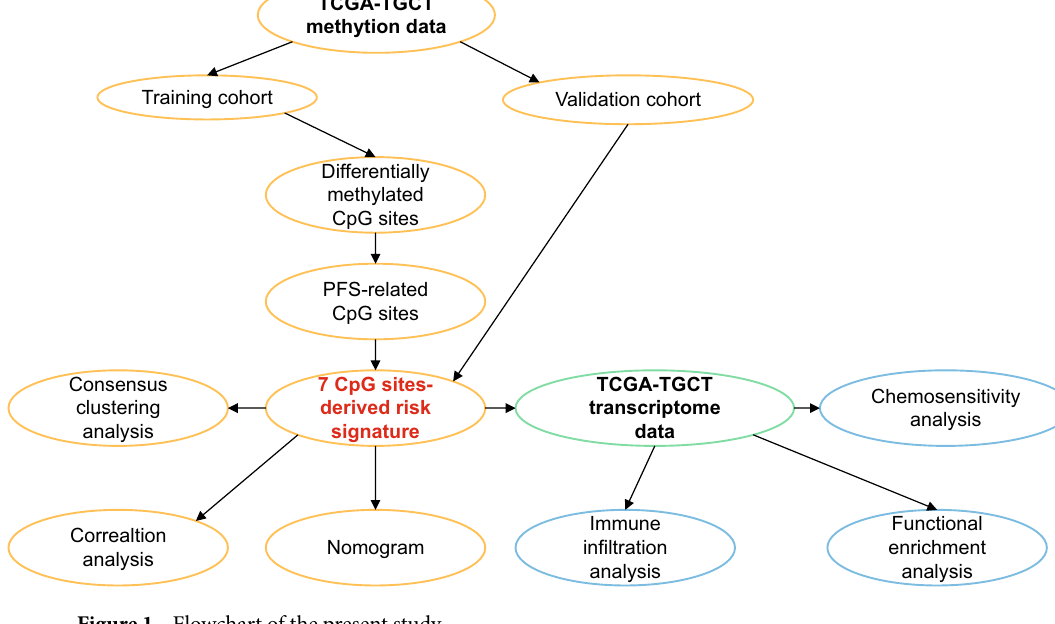
Figure 1. Flowchart of the present